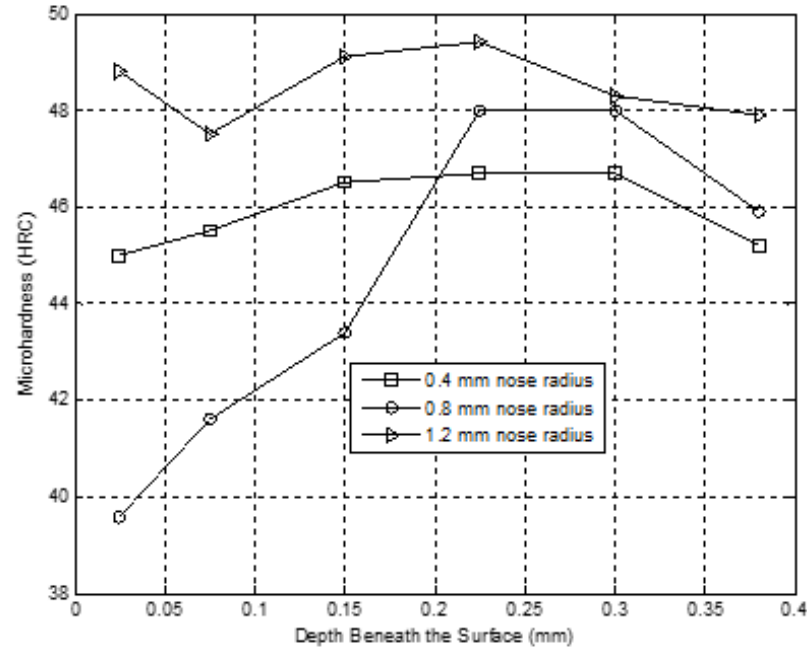
Figure 9: Microhardness of machined surface of Stellite 6 (using coated Carbide inserts)